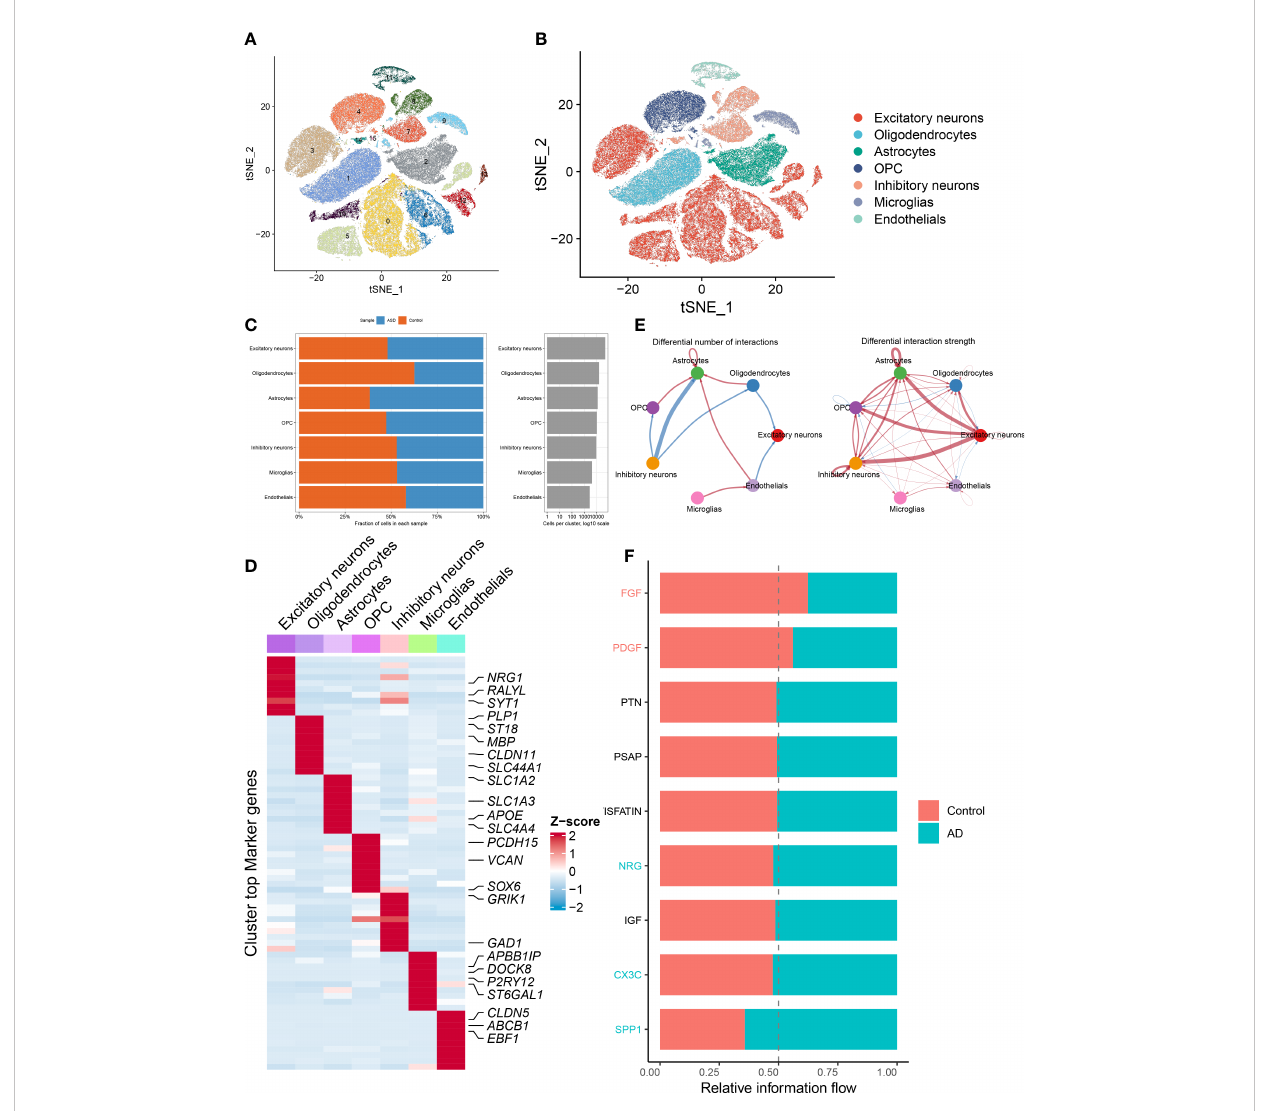
FIGURE 2 Identi fi cation of distinct cell clusters on the basis of snRNA-seq data. (A, B) The tSNE clustering of 101420 single cells from 41 cortical samples, exhibited the generation of 16 main clusters (A) , including 7 for excitatory neurons, 1 for oligodendrocytes, 1 for astrocytes, 2 for OPC, 3 for inhibitory neurons, 1 for microglias, and 1 for endothelials (B) . Each dot corresponds to one cell, and each color corresponds to one cell cluster. (C) A stacked bar chart exhibiting the cell type proportions of each group. (D) A heatmap showing the top 5 distinctive signature genes in each cluster of cellular annotations. (E) Circle plots exhibiting the differences in the number of interactions (left) and strength of interactions (right) in the intercellular communication network between control and ASD groups. The thicker the lines, the stronger the interactions, and the red or blue colors signify increased or decreased signaling pathways in ASD children compared to the control group, respectively. (F) A bar graph illustrating the differences in intercellular pathways between the control and ASD